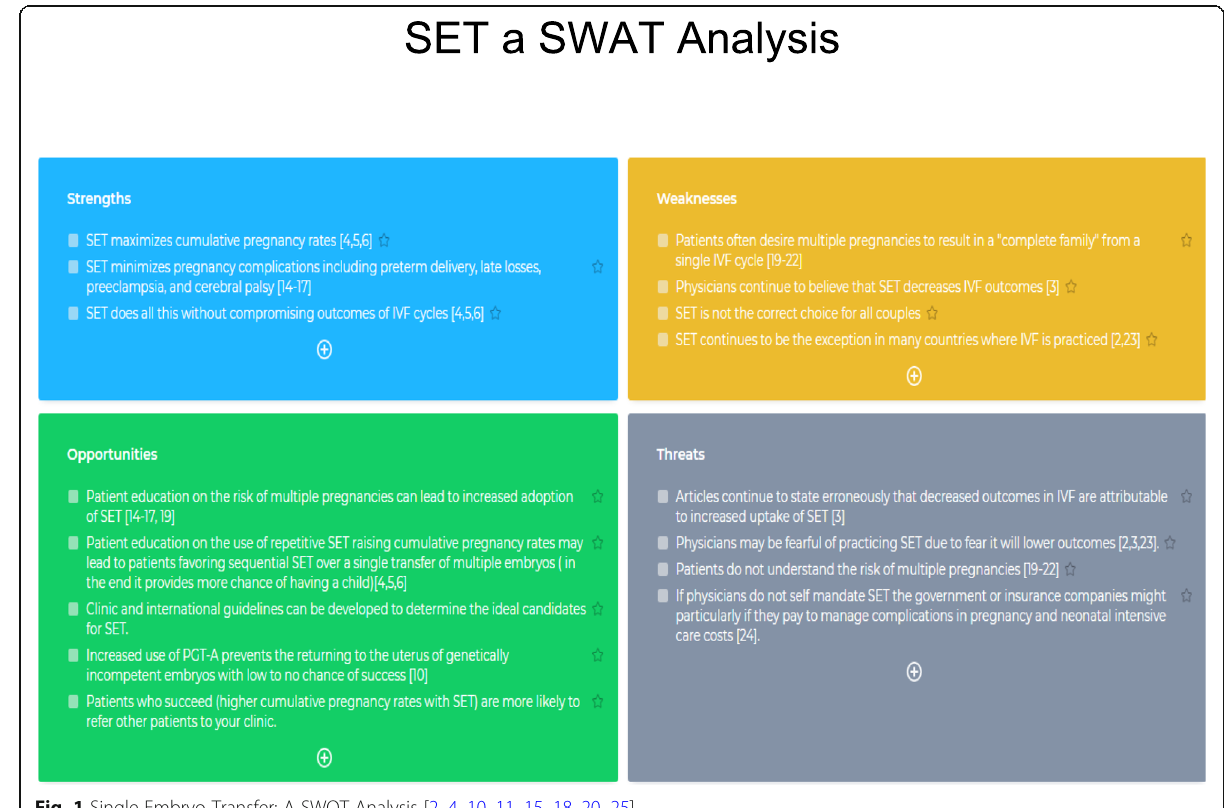
Fig. 1 Single Embryo Transfer: A SWOT Analysis [2 – 4, 10, 11, 15 – 18, 20 –